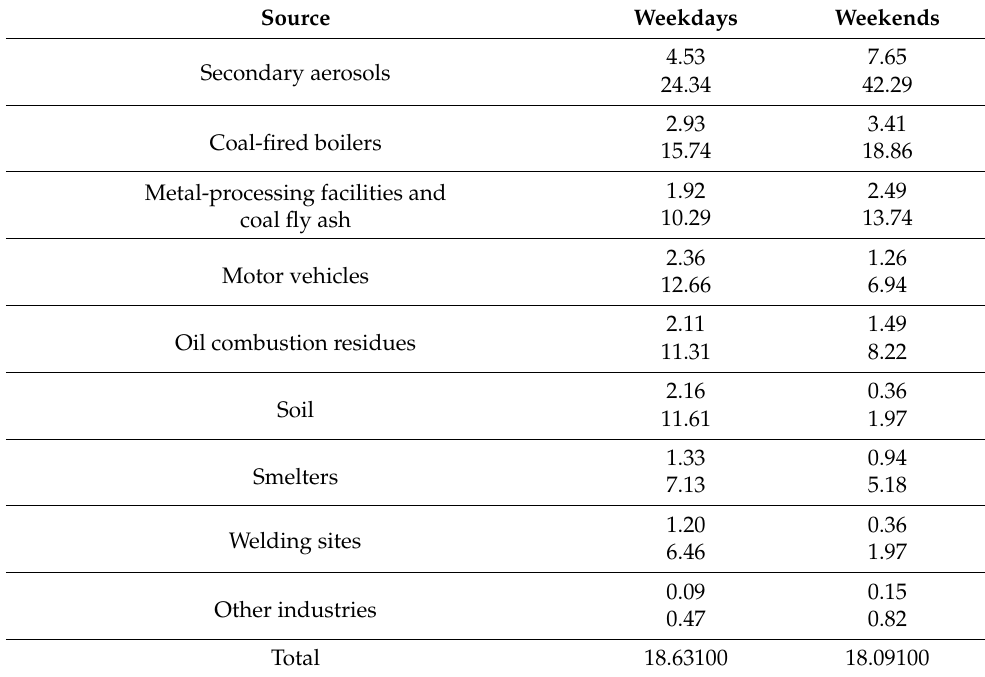
Table 3. Contribution of each pollution source on weekdays and weekends (unit: µ g/m 3 , %).